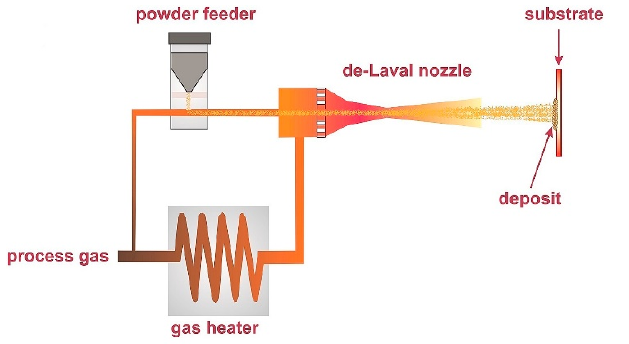
Figure 1. Principle of cold spray technology. Reprinted with permission from [31] Copyright 2021 Elsevier.